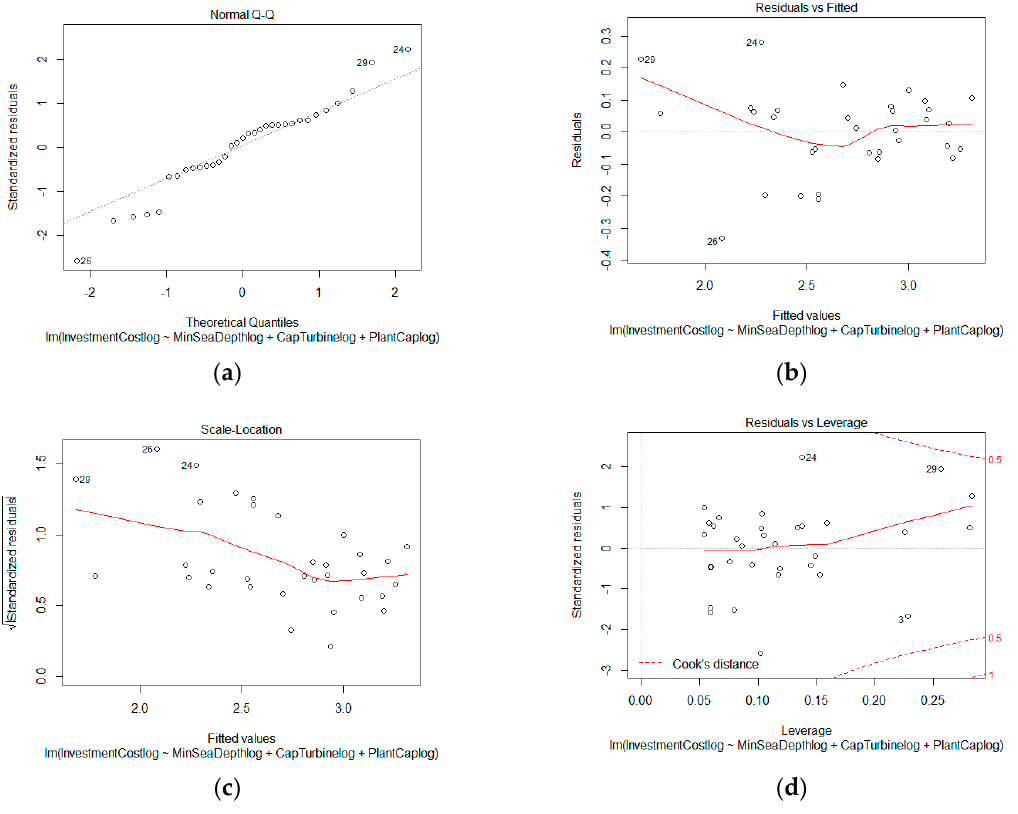
Figure 26. Multiple linear regression test for normality ( a ), linearity ( b ), homoscedasticity ( c ), and reliability ( d ) of model